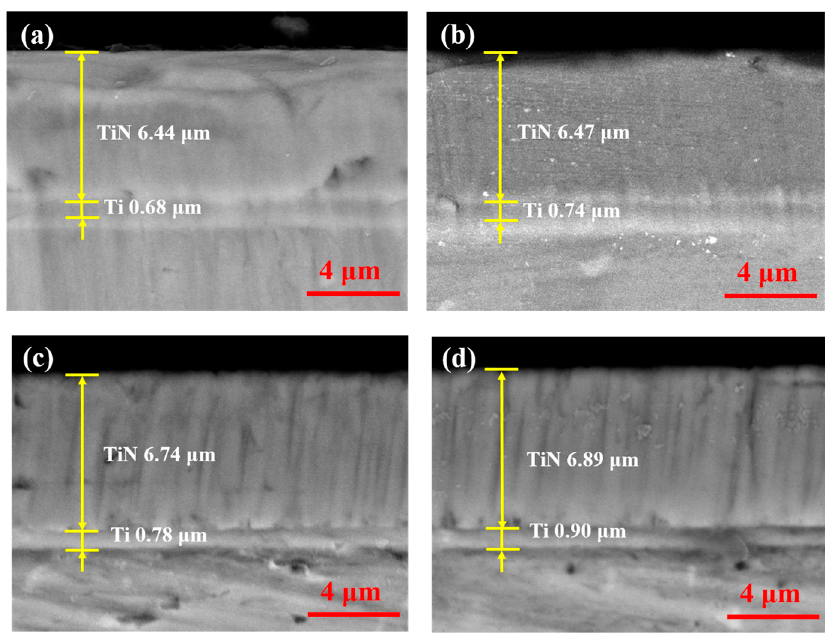
Figure 8. SEM cross-sectional morphologies of TiN coatings under different substrate temperatures: ( a ) Ts35; ( b ) Ts200; ( c ) Ts400; ( d ) Ts600.